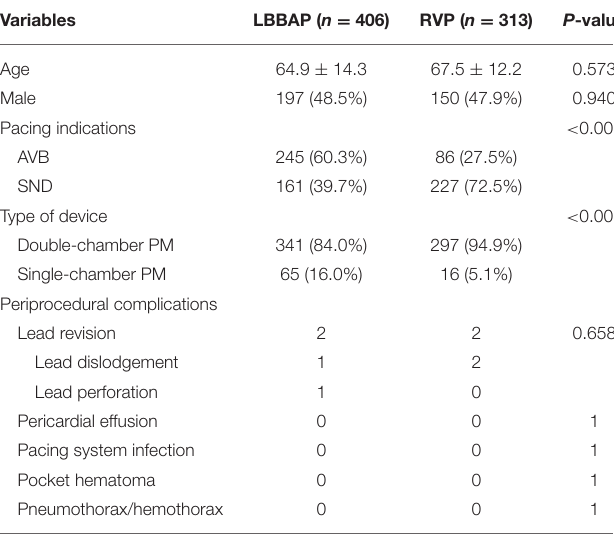
TABLE 3 | Comparison of clinical characteristics and periprocedural complications between LBBAP and